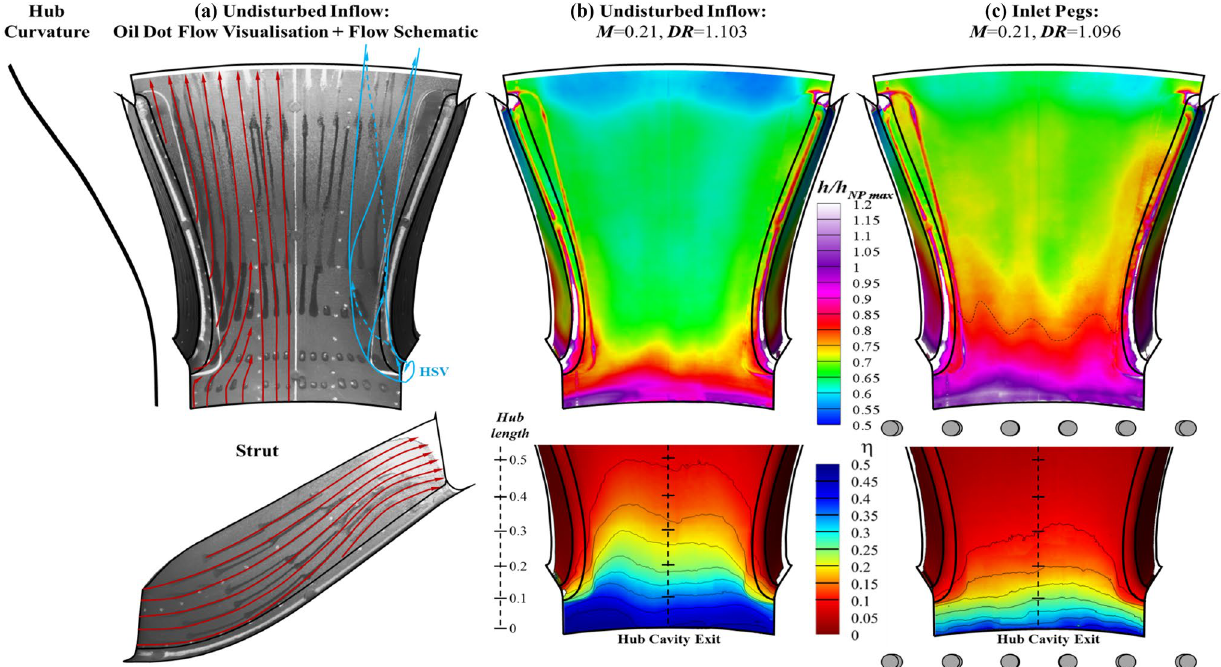
Fig. 9 Oil dot flow visualization, heat transfer coefficient and film cooling effectiveness of the investigated test cases (Horseshoe vortex